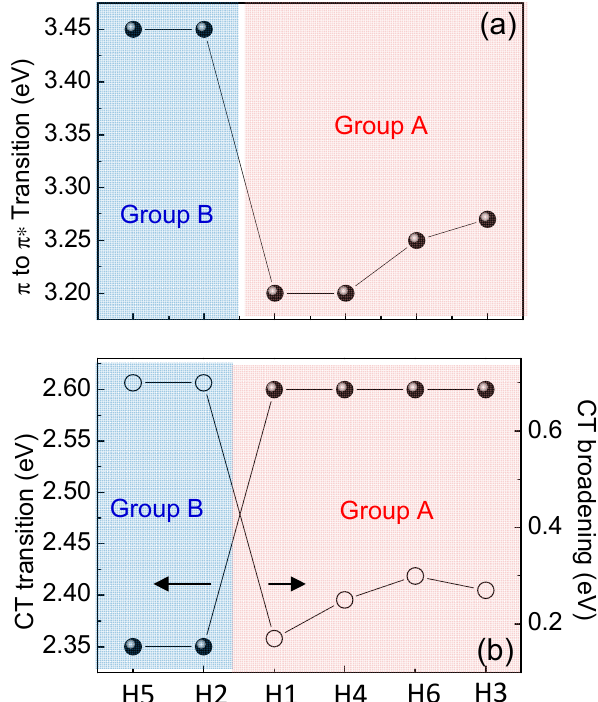
Figure 6. Evolution of the ( a ) π → π * transition and ( b ) position and broadening of the CT transition as a function of molecule type.